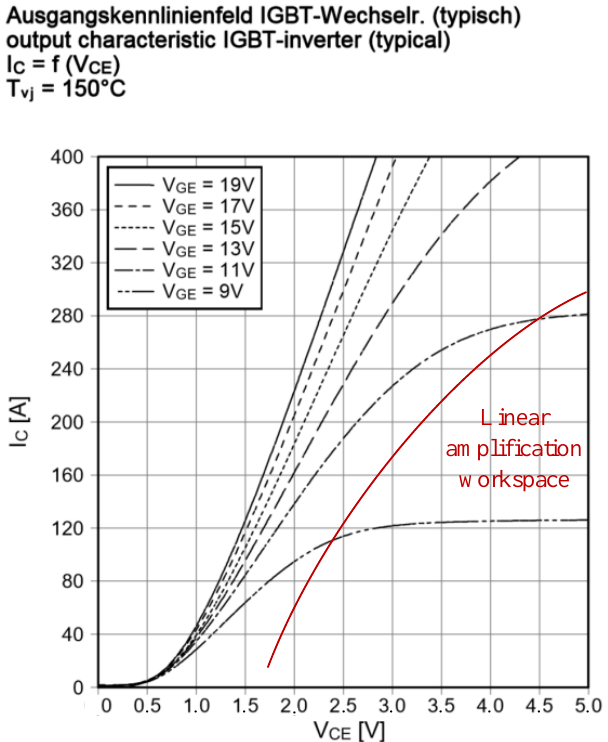
Figure 1. Output characteristic of the Insulated Gate Bipolar Transistor ( IGBT).